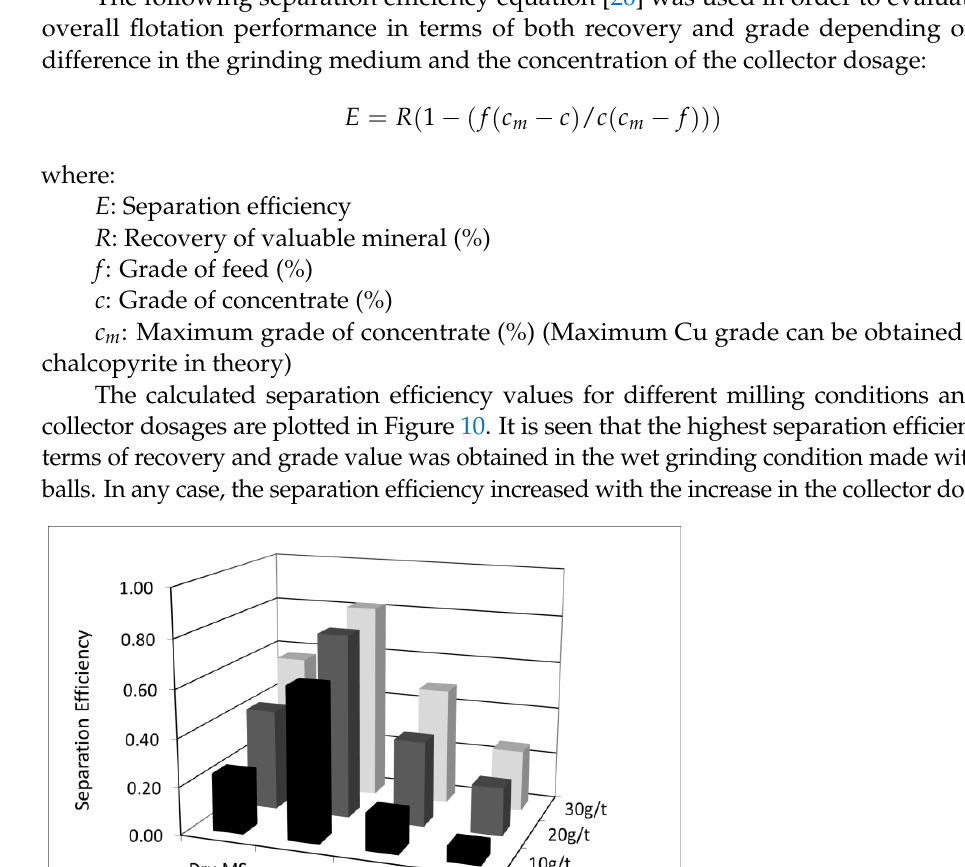
Figure 9. Cumulative Cu grade of the concentrates in flotation after different milling conditions.